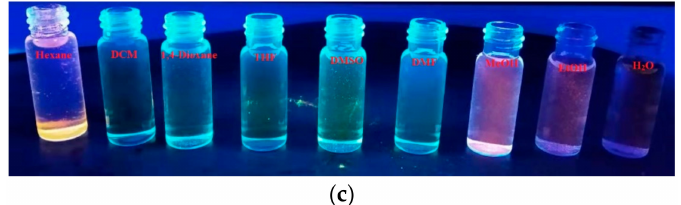
Figure 6. Fluorescence spectra of AIE-2 (20 µ M) in di ff erent ( a ) solvents and ( b ) concentrations excited at 400 nm and ( c ) fluorescence images of AIE-2 (20 µ M) in di ff erent solvents under 365 nm UV